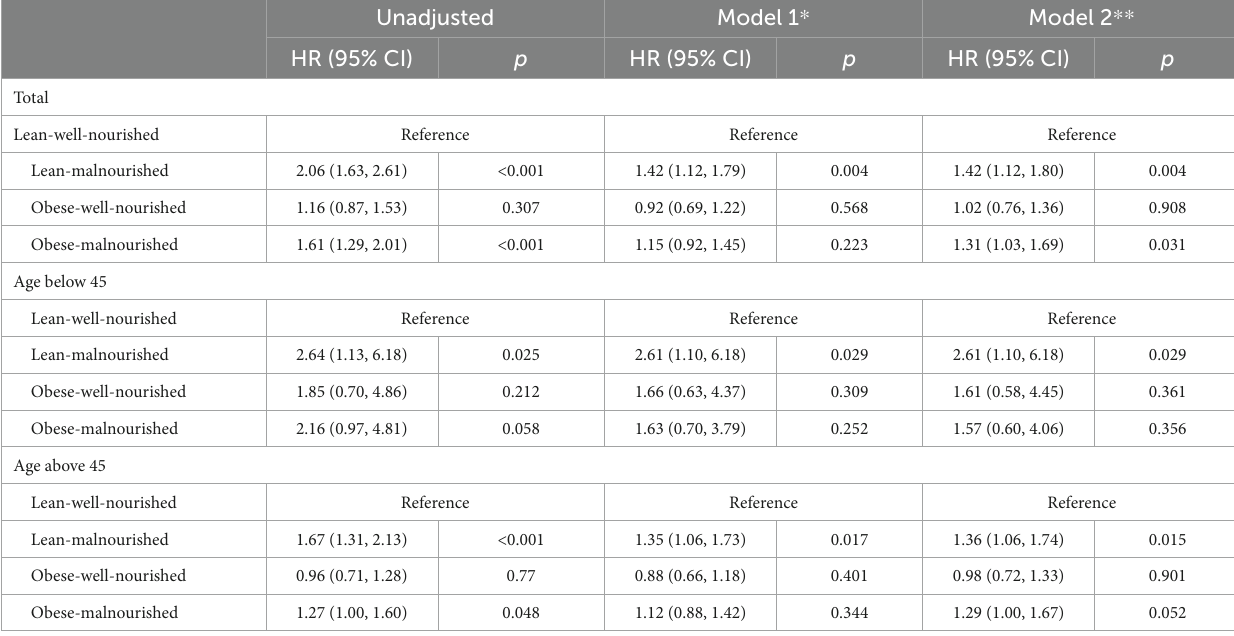
TABLE 4 The association of obesity and malnutrition with all-cause death in participants with